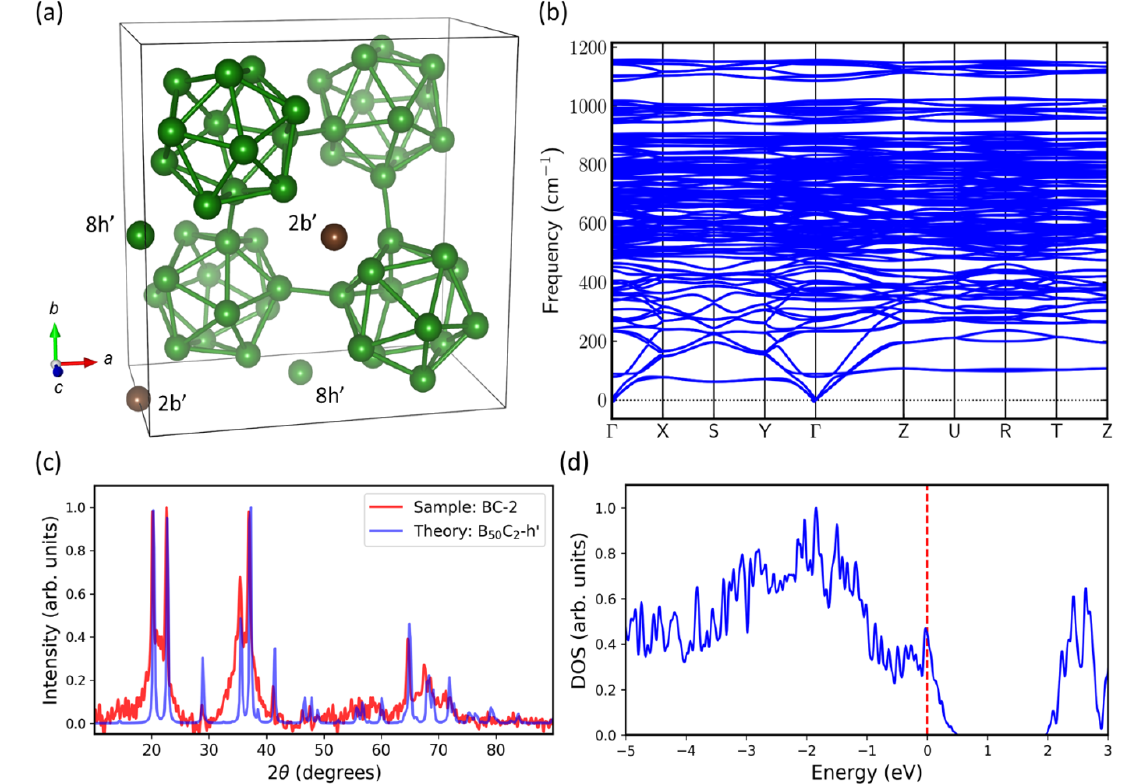
Figure 10. ( a ) The lowest energy structure found in our DFT calculations, B 50 C 2 -8h’. After full structure relaxation, the crystal symmetry changes from tetragonal to orthorhombic. The positions of the two carbon atoms move from 2b (0, 0, 0.5) to 2b’ (0, 0, 0.503), and the two boron atoms move from 8h (0, 0.5, 0.8557) to 8h’ (0, 0.5, 0.7908). ( b ) Phonon dispersion of relaxed B 50 C 2 -8h’ shows that it is dynamically stable. ( c ) Theoretical B 50 C 2 -8h’ XRD pattern (blue) compared to the experimental XRD pattern of sample BC-2 (red). ( d ) Electronic calculations show finite DOS of B50C2-8h’ at the Fermi level (red dashed line).